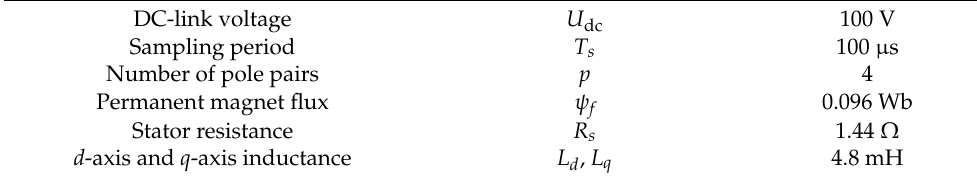
Table 1. Motor and system